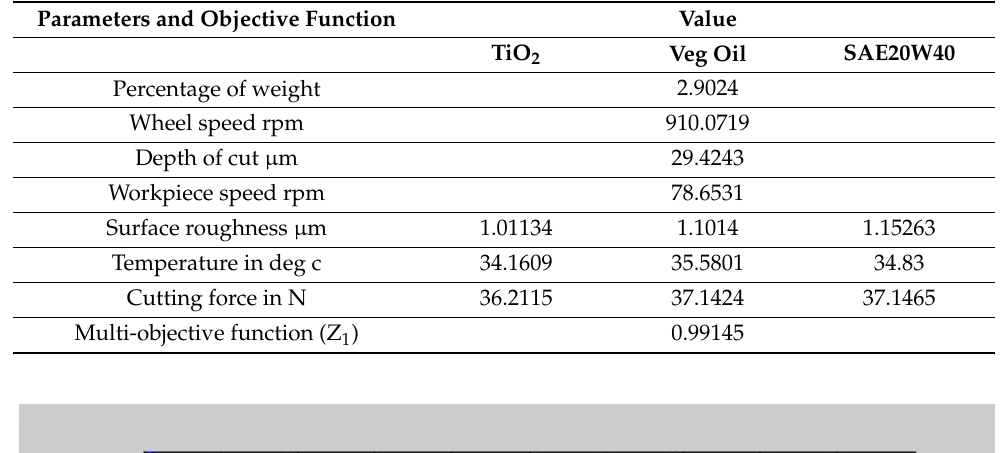
Table 11. Multi-objective optimization results for grinding process.